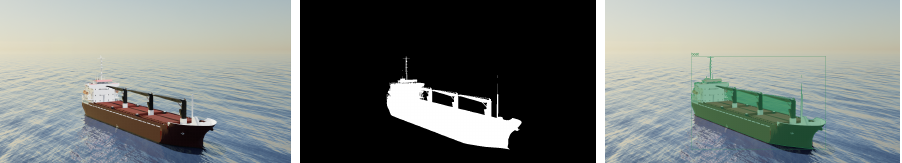
Figure 5. Example of MarSyn dataset annotations. Left: original image; Center: foreground mask; Right: COCO format